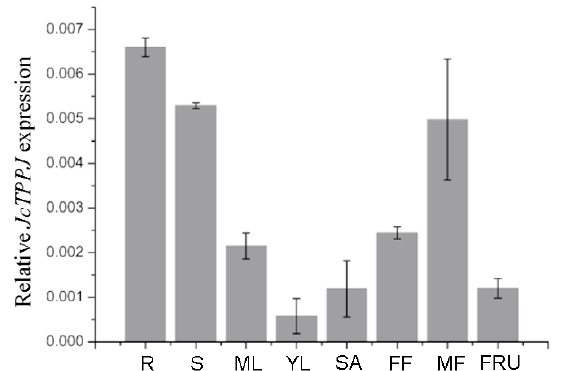
Figure 2. The transcriptional level of JcTPPJ in various organs of adult Jatropha plant. The qRT ‐ PCR results were obtained from three independent biological replicates per sample. The levels of detected amplification were normalized via the amplified products of the JcGAPDH genes as a reference. The error bars represent the standard errors. R, roots; S, stems; ML, mature leaves; YL, young leaves; SA, stem apices; FF, female flowers; MF, male flowers; FRU, fruits.